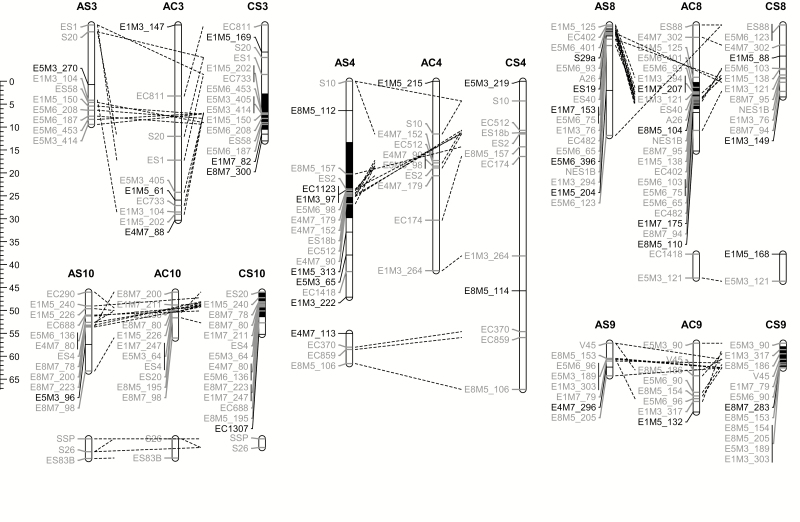
Interleaved genetic maps of selected linkage groups (LGs) from the F2AC, F2AS and F2CS mapping families. Map distances in Kosambi centiMorgans are shown in the scale to the left of LGs. Linkage groups are represented by vertical bars with mapped marker positions indicated with horizontal lines. Linkage group names are presented in bold above each LG with letters indicating the pair of F0 species; S. aethnensis (A), S. chrysanthemifolius (C) or S. squalidus (S) that founded the mapping family and numbers indicating equivalent LGs that share genetic markers across the three maps. Weakly linked LGs that are thought to belong to the same chromosome are aligned vertically under a single overall LG name. Marker names are listed to the left of LGs in grey if they are common to another genetic map or in black if they are uniquely present on that genetic map. Dotted lines link common marker positions on the equivalent LGs of different genetic maps. Black shaded portions of LGs indicate chromosomal transversions identified from switches in marker order compared with equivalent LGs. See Supporting Information—Figure S1 for a depiction of all LGs corresponding to 10 chromosomes.